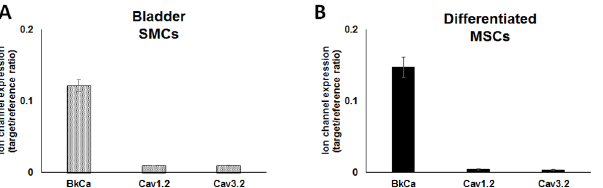
Fig 9. Expression levels of potassium and L- and T-type calcium ion channels. (A) Bladder SMCs were compared to (B) MSCs treated with SMC differentiation medium for 7 days for expression of ion channels. Transcript levels of KCNMA1 (potassium ion channel), CACNA1C (Ca v 1.2 L-type Ca 2+ channel) and CACNA1H (Ca